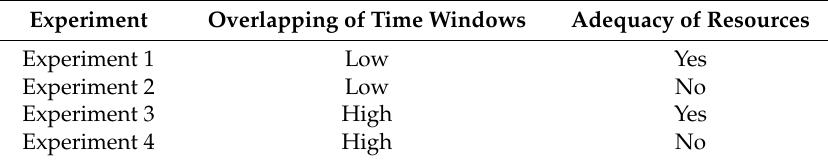
Table 3. Experimental arrangements.